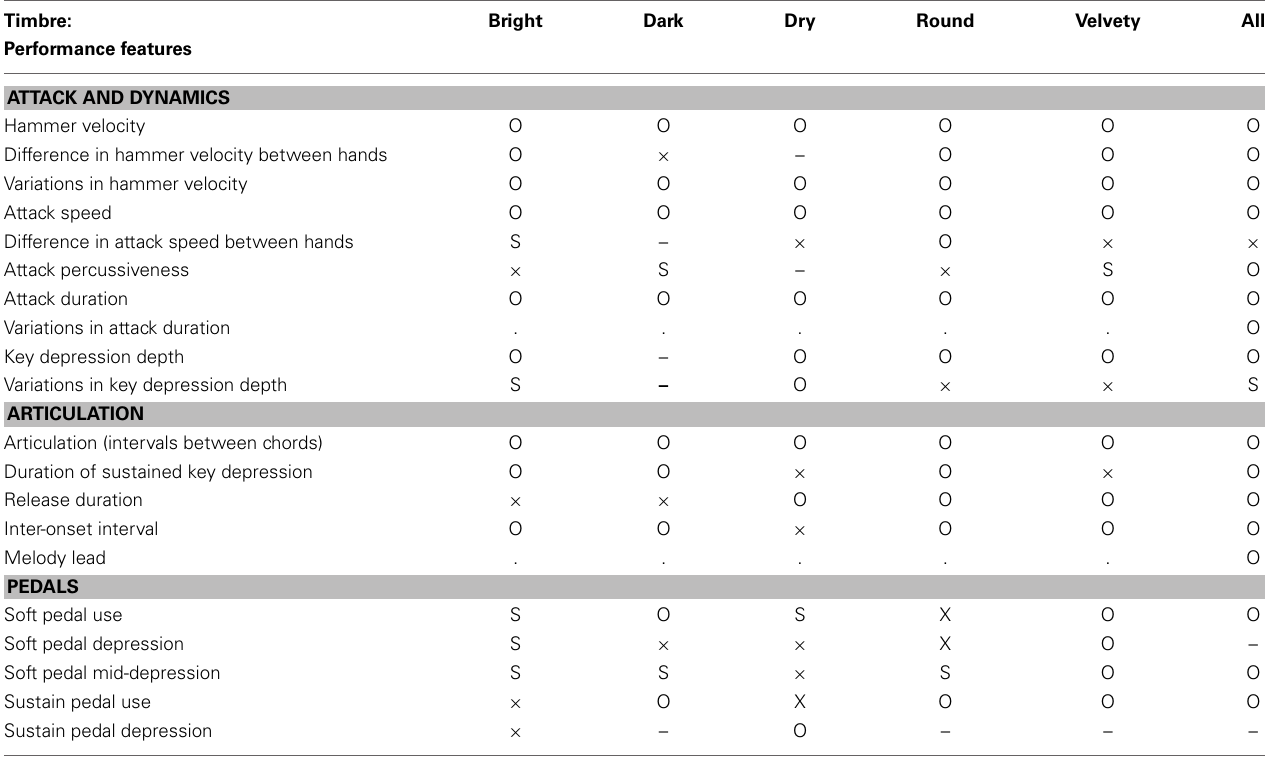
Table 1 | Performance features most characteristic of pianists’ individuality, in performing five timbral nuances and overall.